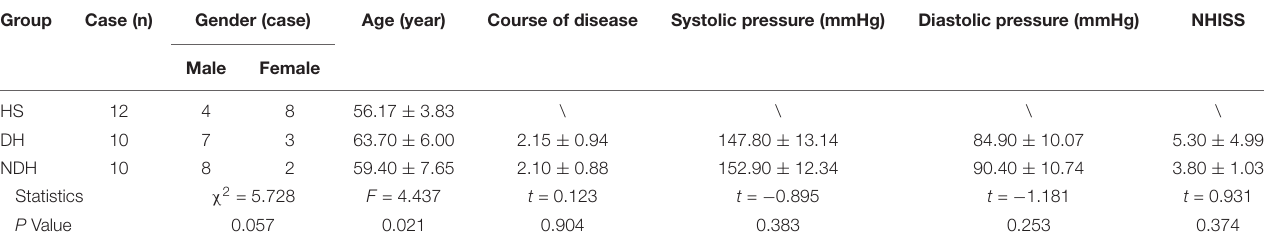
TABLE 1 | Demographic and clinical characteristics of all patients in three